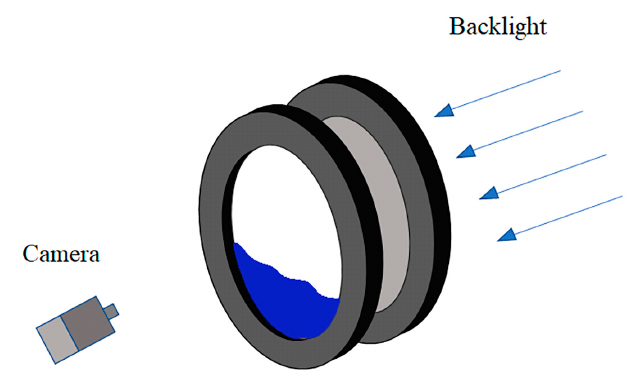
Figure 3. Schematic of BE measurement.